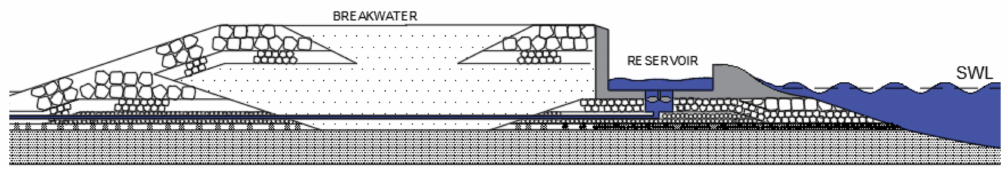
Figure 2. Overtopping breakwater for energy conversion